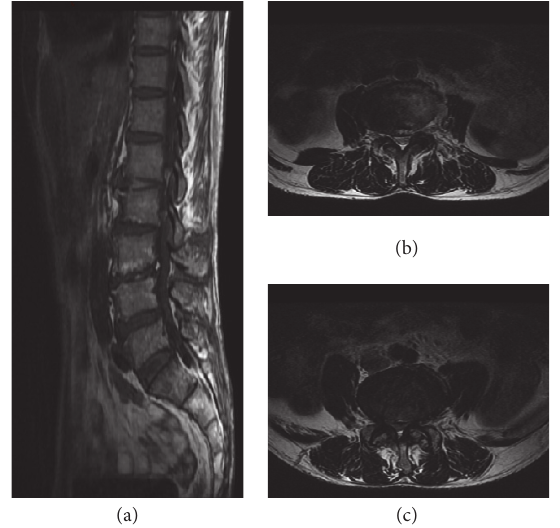
Figure 3: Both the T1 sagittal (a) and coronal MRI images of L3-4 (b) and L4-5 (c) suggested that the herniation and lumbar stenosis compressed the thecal sac at both levels, and lumbar degenerative changes were also